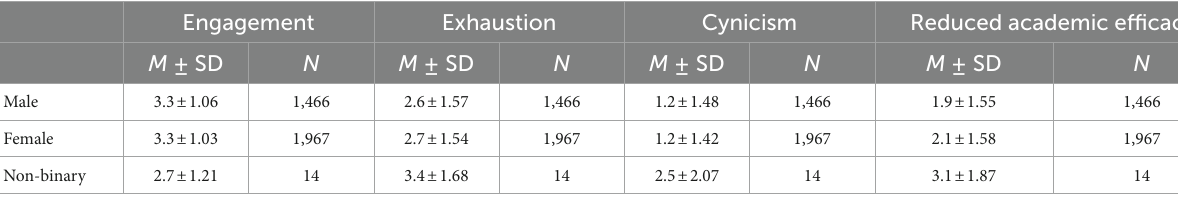
TABLE 1 Means of the dimensions of the Maslach-Burnout-Inventory Short Form for Students (MBI-SS) and the sum score of Utrecht Work Engagement Scale for Students (UWES-S) among the genders.